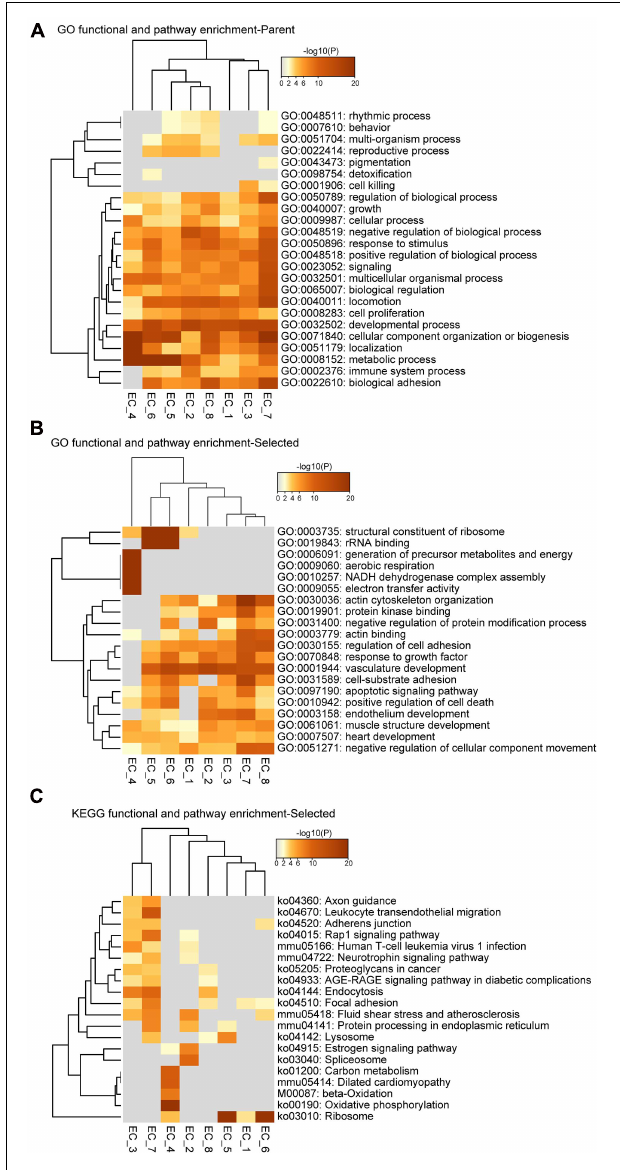
FIGURE 3 | Functional and pathway enrichment analysis of endothelial cell subpopulations. (A – C) , Heatmap showing the Gene Ontology (GO) and KEGG-terms enrichment of all the cluster-specific genes for the 8 EC